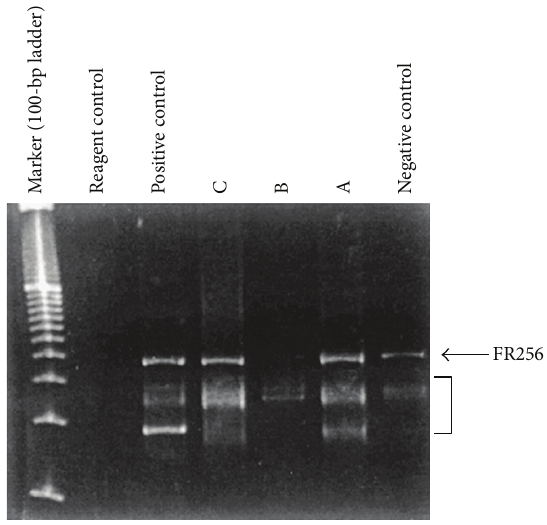
Figure 3: Case 4: B-cell-specific polymerase chain reaction using primers directed at the framework 256 (FR256) regions of the immunoglobulin heavy-chain gene (IgH). The top arrow represents the internal control that is used to ensure the presence of amplifiable DNAineachsample.ThebracketintheFR256figuredenotesthesize range in which IgH gene products can be seen. Although the DNA is degraded and the signal is weak, patient B (case 4) clearly shows the presence of a clonally rearranged IgH gene using the FR256 primers. Clonal rearrangements of IgH genes were also noted in cases 1 and 2 (not shown in figure). Lanes A and C are from cases unrelated to this paper. Reproduced from [4] with permission of the Editor-in- Chief of Archives of Pathology and Laboratory Medicine on behalf of the editorial team of the journal and the American Association of